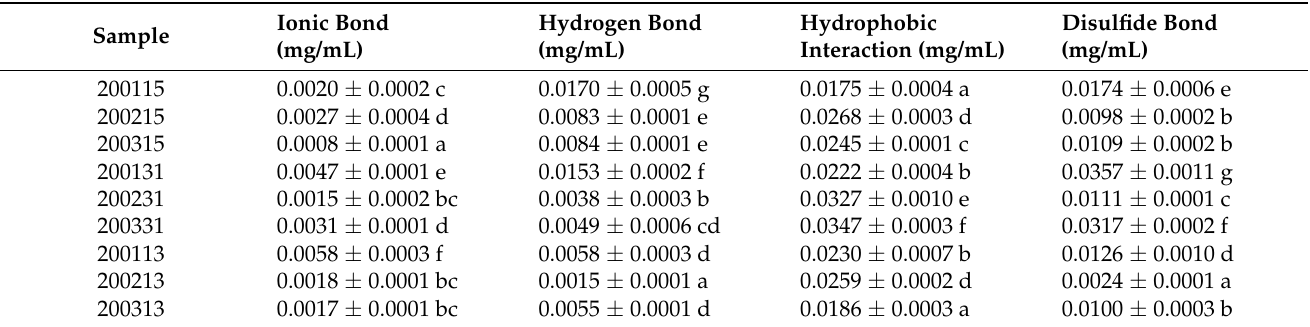
Table 4. Quantitative changes of different chemical bonds in different recombinant